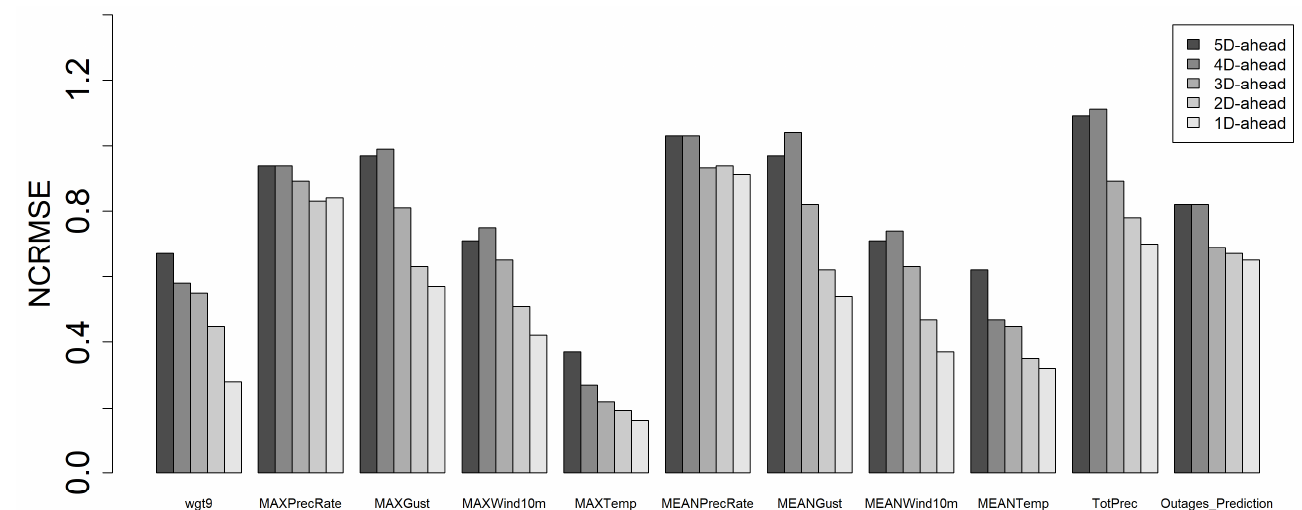
Figure 6. NCRMSE of weather forecast and outage prediction for different lead times.